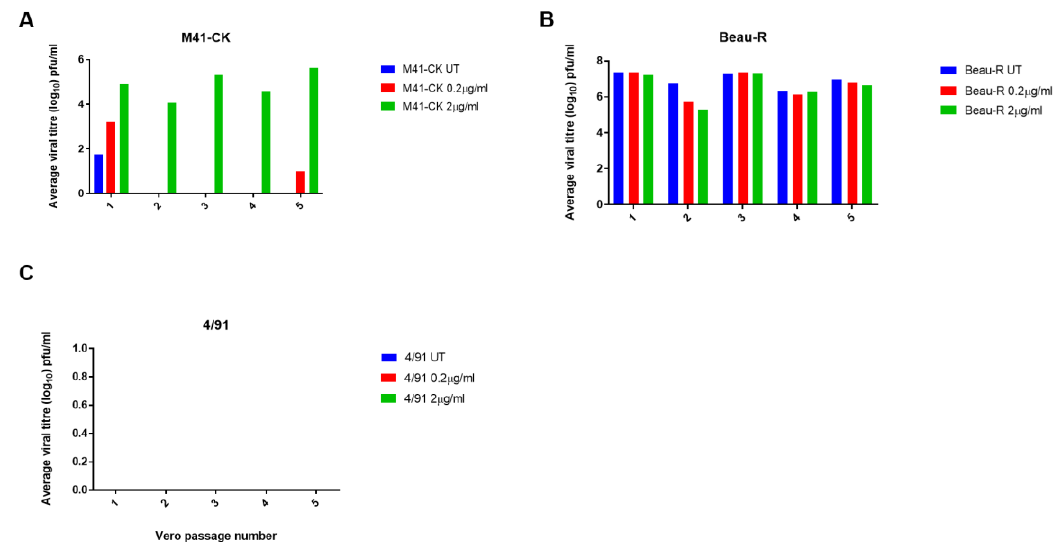
Figure 2. IBV replication in Vero cells is maintained over passage with trypsin in a strain-dependent manner. Three strains of IBV were passaged in Vero cells five times in the presence of TPCK-treated trypsin at a high (2.0 µg/mL) and low (0.2 µg/mL) concentration alongside untreated (UT) samples of each strain. Cells were infected with each IBV diluted at a ratio of 1:1 in serum free BES media containing each concentration of TPCK-treated trypsin. Supernatant was harvested at 48 hpi and used for the subsequent passage following the same protocol. Supernatant from each passage was titrated on CK cells in triplicate and viral titres were calculated (pfu/mL). The average viral titre at each passage is shown for M41-CK ( A ), Beau-R ( B ) and 4/91 ( C ).